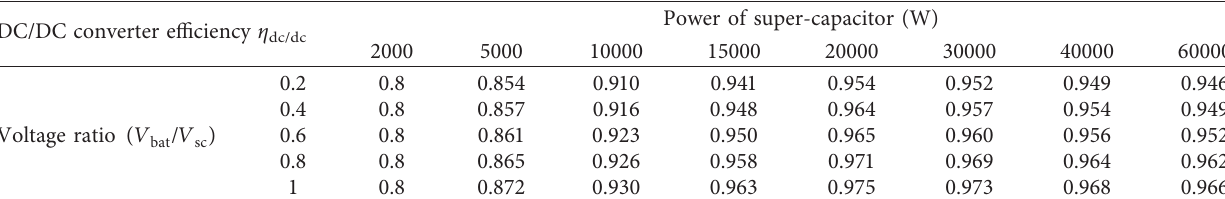
Table 1: Efficiency interpolation table of DC-DC